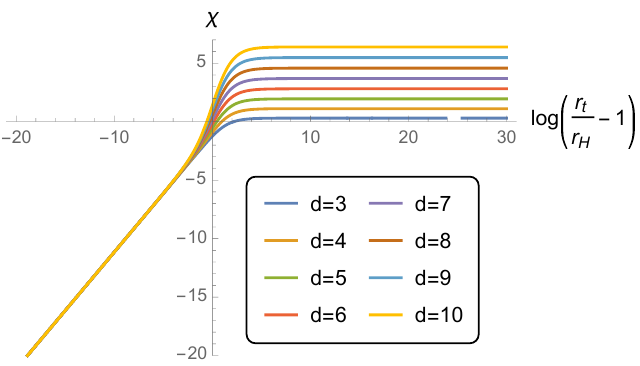
Figure 2 . Correction to the echo-Log, (cid:31) (de(cid:12)ned in eq. (2.10)) as a function of the upper bound on echo integral (eq. (2.2)) for a d + 1-dimensional planar (or large spherical) black hole. We see that (cid:31) asymptotes to a (cid:12)nite value given by eq. (3.8) for (cid:31) 1